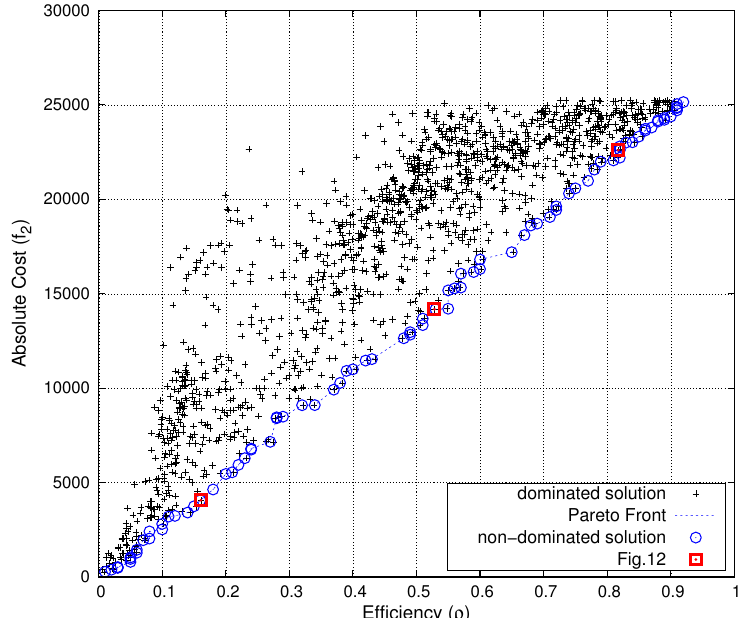
Figure 11. Pareto front (in blue) of f 1 (network sensing coverage) vs . f 2 (network cost). Deployments of Figure 12 in